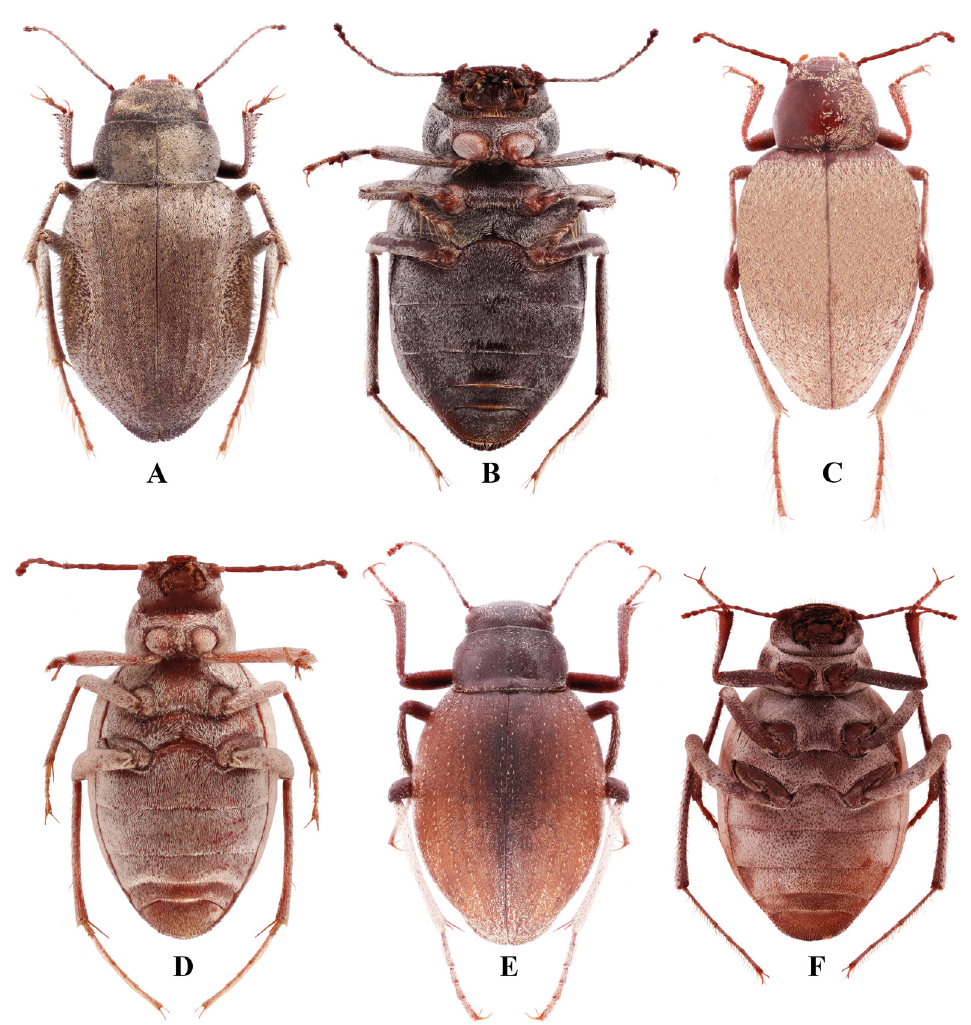
Fig. 1. Species of the genera Apatopsis Semenov, 1891, Habrochiton Semenov Tjan-Shansky, 1907 and Habrobates Semenov, 1903, habitus. A . A. grombczewskii Semenov, 1891, ♀, paralectotype (ZIN), dorsal view. B . Ditto, ventral view. C . Habrochiton vernus Semenov-Tjan-Shansky, 1907, ♀, paralectotype (ZIN), dorsal view. D . Ditto, ventral view. E . Habrobates vernalis Semenov, 1903, ♂, paralectotype (ZIN), dorsal view. F . Ditto, ventral